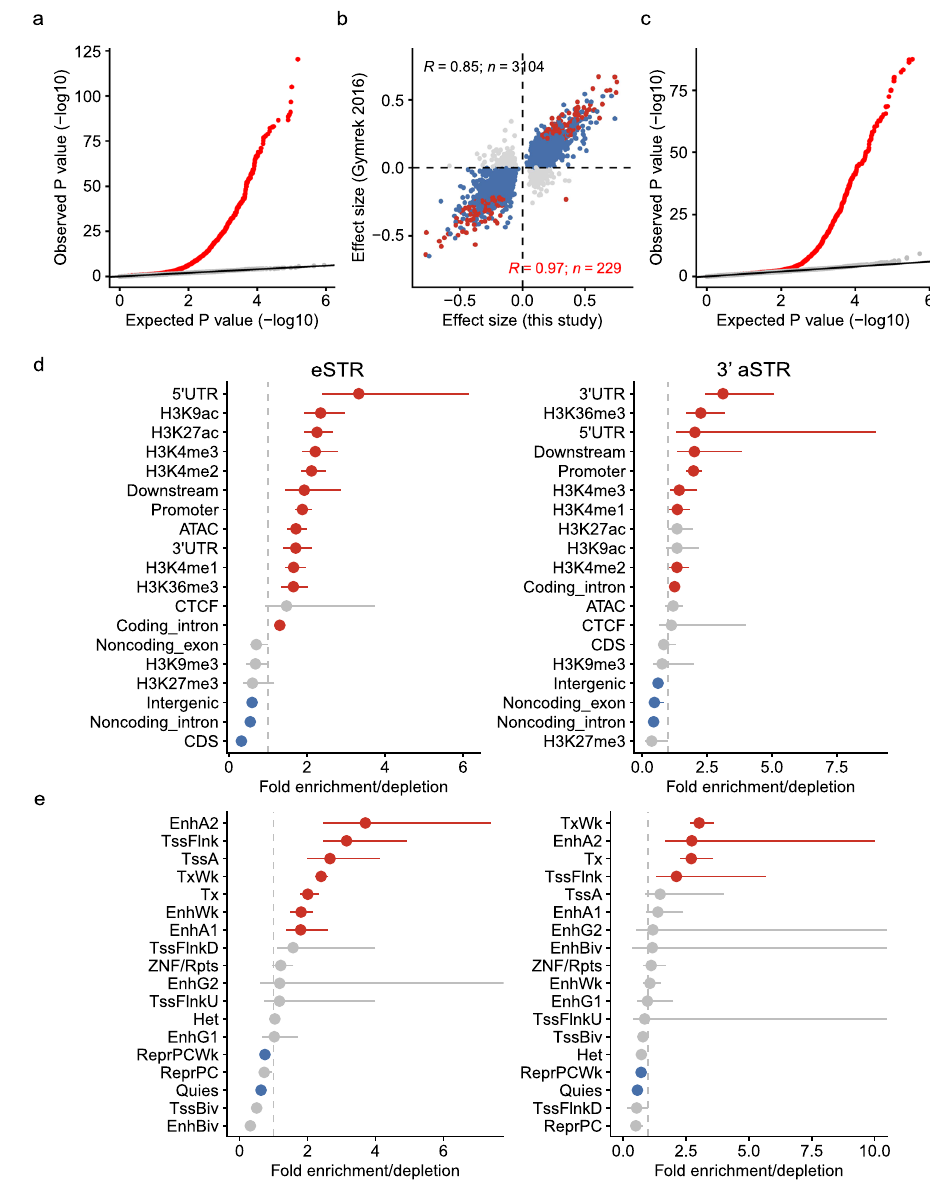
Fig. 4 | eSTRs and 3 ′ aSTRs identi fi ed in this study. a Quantile ‒ quantile plot comparing observed P values for STR-gene association tests (two-sided t -test in linear model) versus the expected uniform distribution in eSTR analysis. The red dots represent the observed association tests, and the gray dots indicate P values for permutation control. The black line gives the expected P value distribution under the null hypothesis of no association. b Correlations of the effect size of eSTRsidenti fi edinthisstudyandapreviousstudybyGymreketal.Thebluepoints indicateeSTRswhosedirectionsofeffectwereconcordantintwostudies,andgray points denote eSTRs with discordant directions of effect for that eSTR. The eSTRs detected in both studies are colored red, regardless of the concordance of effect.